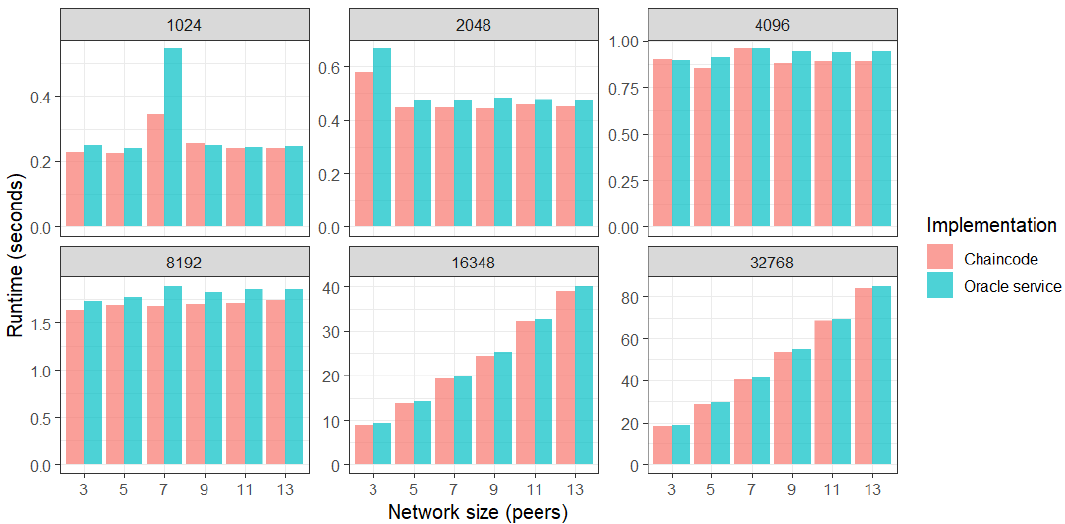
Figure 11. Model inference runtime (in seconds) depending on the network size for different amounts of EEG (electroen- cephalogram) eye state dataset.